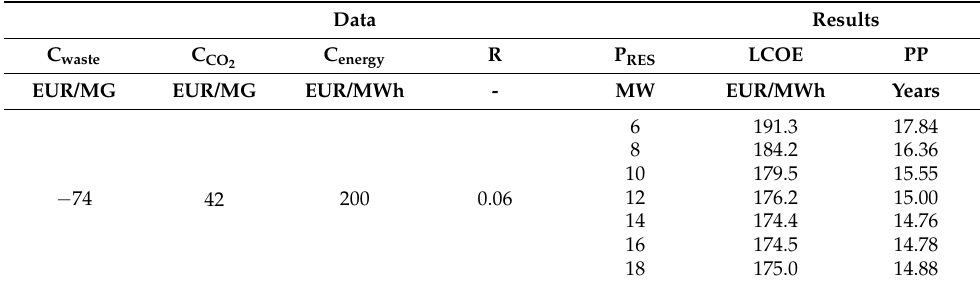
Table 9. Results of economic analysis.